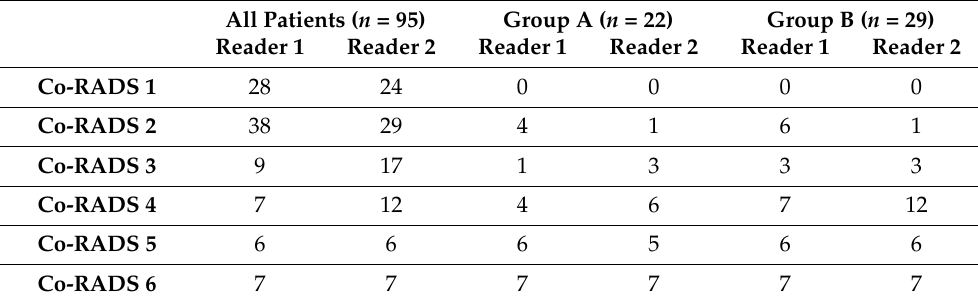
Table 3. Results from Co-RADS